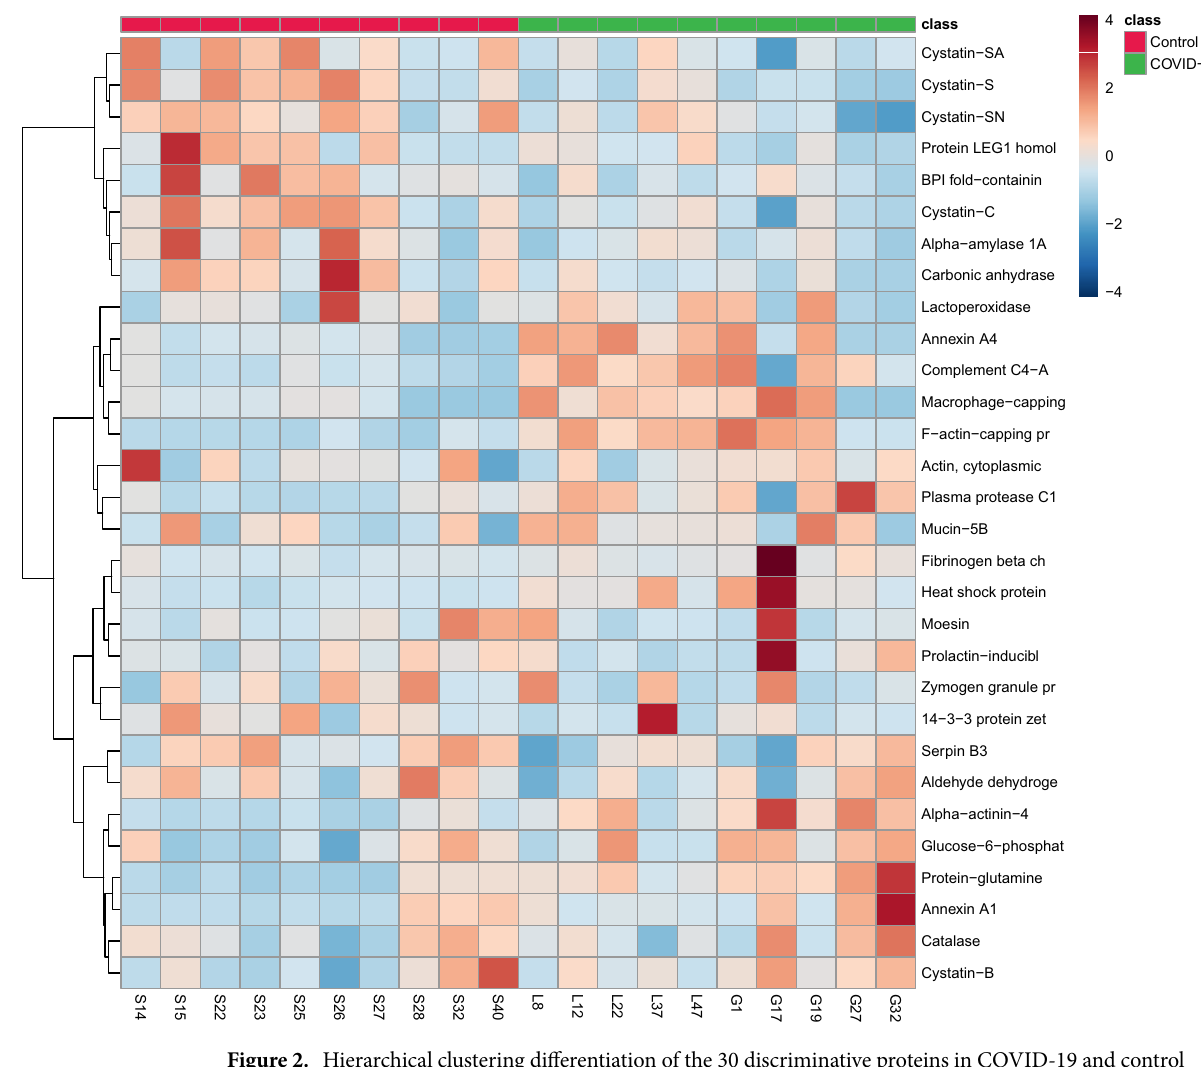
Figure 2. Hierarchical clustering differentiation of the 30 discriminative proteins in COVID-19 and control patients. Horizontal columns: relative abundance of each biologically relevant protein displaying distinct metabolic patterns between COVID-19 and control group. Each bar in the horizontal columns represents the relative abundance of the protein, where red bands indicate upregulated proteins and blue bands indicate downregulated proteins in the two groups. Source: Metaboanalyst 5.0 (https:// www. metab oanal yst.